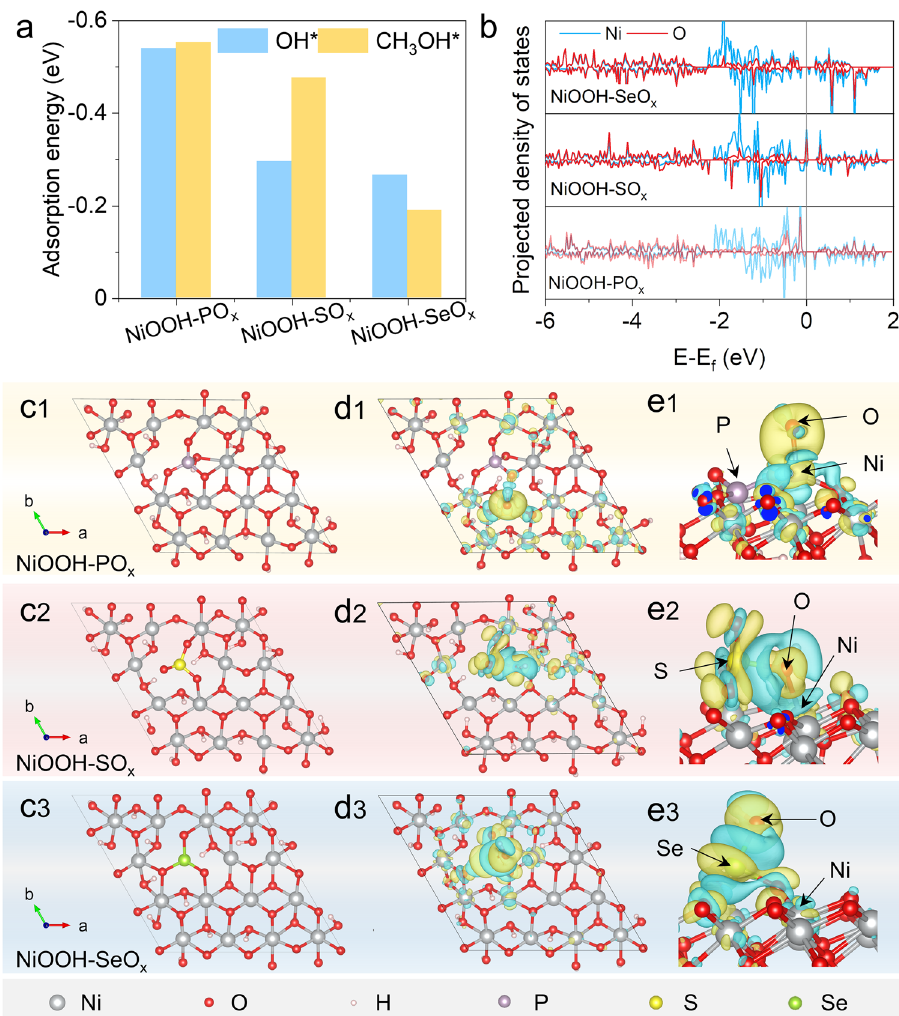
Fig. 6 DFT calculations. a Adsorption energies of OH* and CH 3 OH* on NiOOH-PO x , NiOOH-SO x , and NiOOH-SeO x . b PDOS plots of Ni 3 d and O 2 p band for NiOOH-PO x , NiOOH-SO x , and NiOOH-SeO x . c 1 – c 3 The slab models of NiOOH-PO x , NiOOH-SO x , and NiOOH-SeO x . d 1 – d 3, e 1 – e 3 Charge density difference of OH intermediates adsorption on NiOOH-PO x , NiOOH-SO x , and NiOOH-SeO x , respectively. Cyan and yellow represent the depletion and accumulation of electrons,